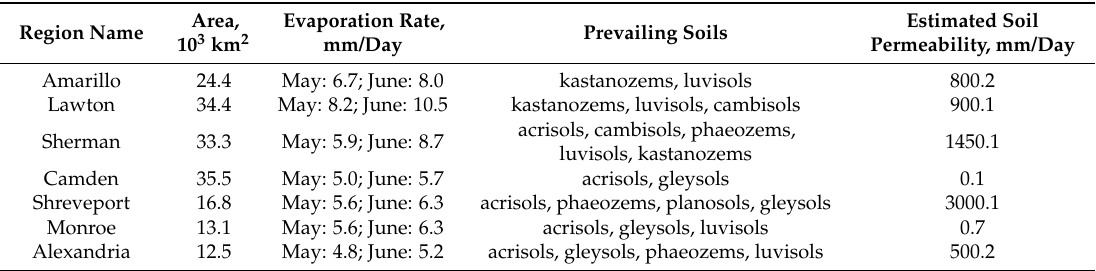
Table 2. The parameters of the Red River basin regions.